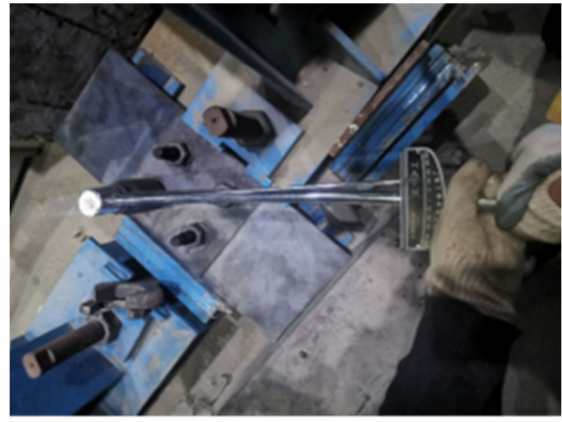
Figure 5. Initial twist of high-strength bolts.